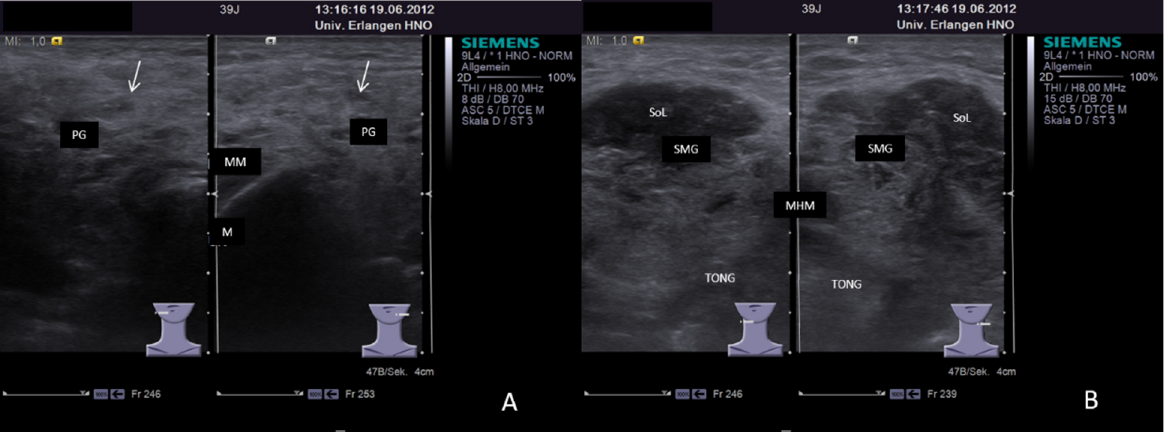
Figure 18. ( A , B ) Thirty-nine-year-old patient with involvement of all glands by histology-proven sarcoidosis. The parenchyma of the PGs has a heterogeneous, more fine-granulated and coarse aspect caused by diffuse hypoechoic areas, supposably caused by infiltration of granulocytes (white arrows, A ). The SMGs are enlarged by diffuse hypoechoic infiltration, which was focally pronounced in the caudal part ( B ). Abbreviations: PG, parotid gland; SMG, submandibular gland; M, mandible; MM, masseter muscle; MHM, mylohyoid muscle; TONG, tongue; SoL, space occupying lesion.